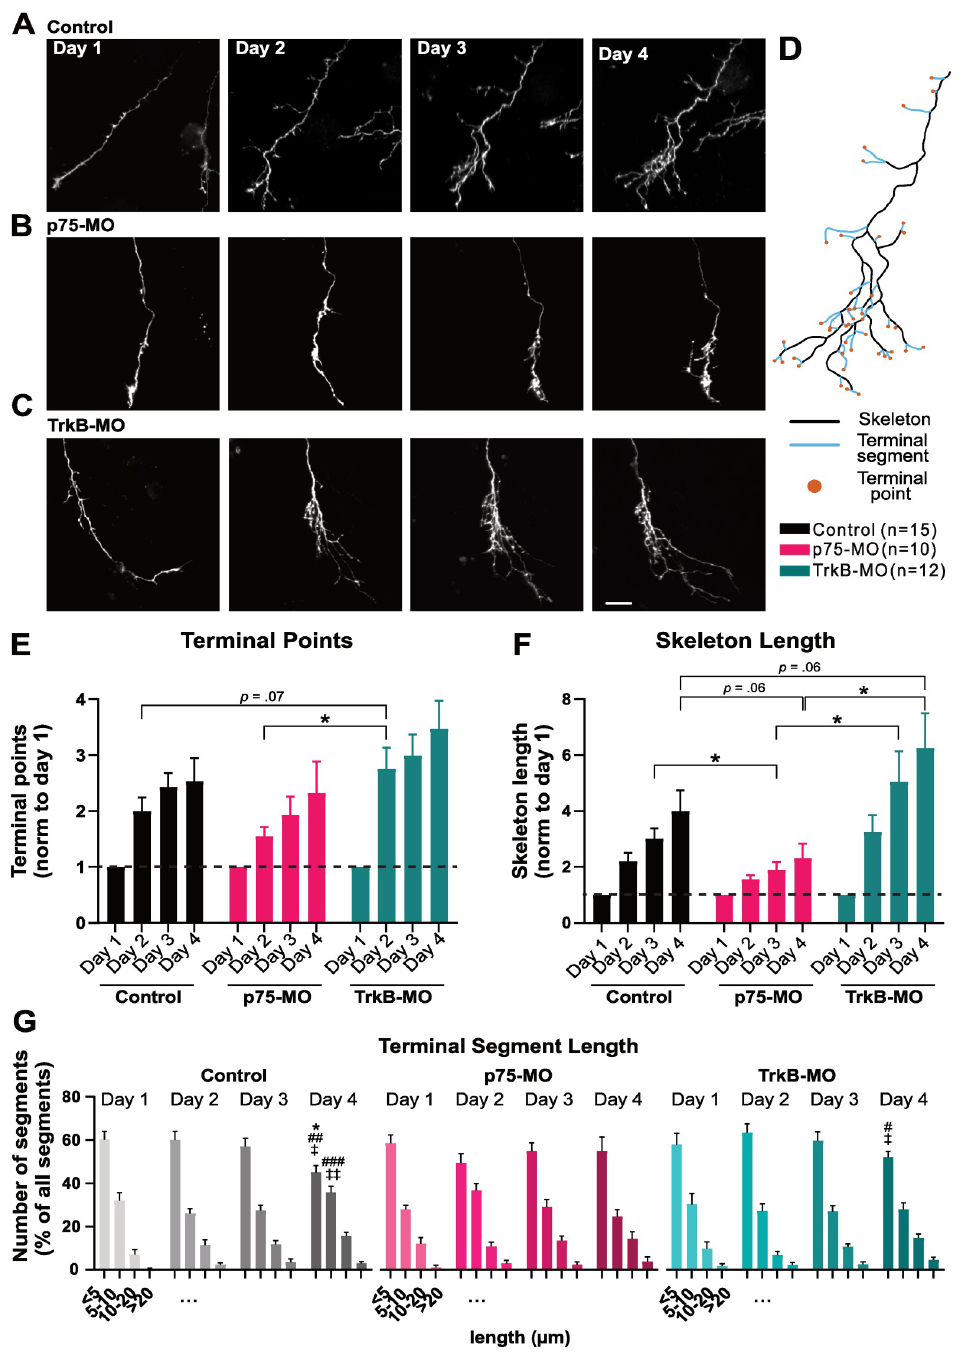
Fig 3. Effects of retinal TrkB-MO and p75-MO on contralaterally projecting RGC axonal arbor elaboration over days. (–C) Two-photon z-series projections over 4 days for axons co-electroporated with EGFP and (A) Ctrl-MO, (B) p75-MO, (C) TrkB-MO. (D) Reconstructed control arbor from day 4 showing axonal skeleton (black), terminal segments (blue), and terminal points (orange). (E, F) Morphometric analysis including (E) number of terminal points and (F) skeleton length, normalized to day 1. (G) Distribution of terminal segments (percent of total per axon) binned by length. Significant interactions in the two-way mixed design model: (E, F) p < 0.001; (G) p = 0.04394 ( < 5 μ m bin); p = 0.01981 (5–10 μ m bin). Post hoc tests corrected for multiple comparisons (BKY two-stage linear step-up procedure): (E, F) * p � 0.05, ** p � 0.01, and (G) comparison between day 1 and day 4, (G) comparison between day 2 and day 4: # p �